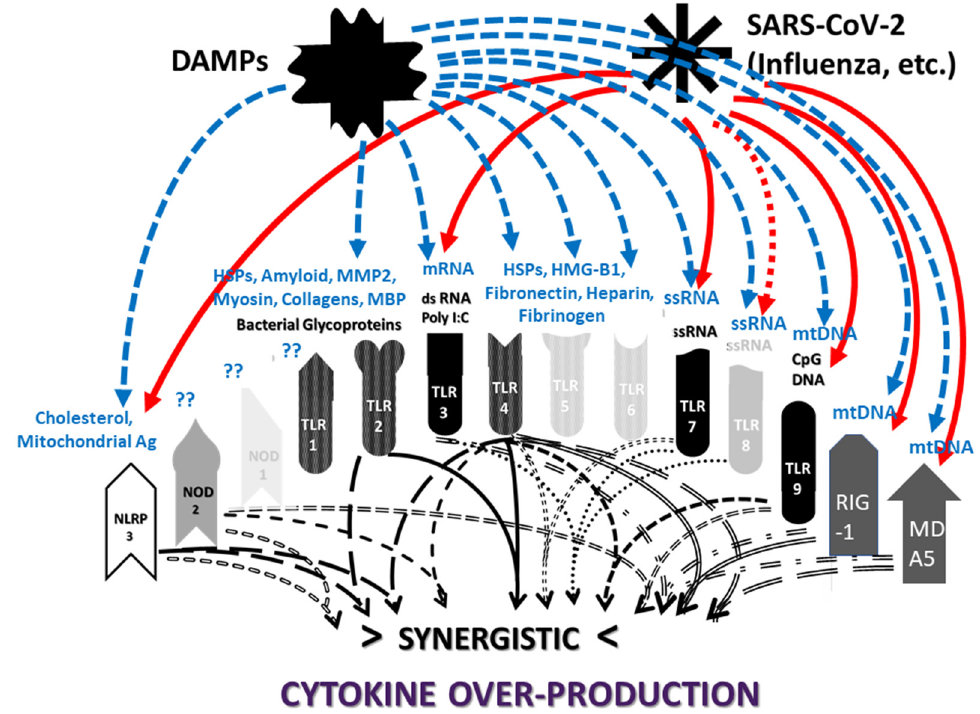
Figure 12. Summary of innate receptor activations produced by SARS-CoV-2 (red lines), damage-associated molecular pattern (DAMP) antigens (blue lines) and their synergisms. Solid red lines indicate activation of receptors that have been well-validated by experimental or clinical studies. Dotted red lines indicate possible activation by SARS-CoV-2 antigens that are not well-established. Dotted blue lines indicate receptor activation by DAMPs that may or may not be released in any given patient with severe COVID-19 and may therefore be disease-, organ-, or tissue-specific. The black lines indicate pairs of receptors involving well-established activation patterns that produce synergism in COVID-19 (see Figure 11). Ag = antigens; ?? indicates that DAMP activators are not known; HSP = heat-shock proteins; MMP2 = matrix metalloproteinase-2 (collagenase); MBP = myelin basic protein; mRNA = messenger ribonucleic acid; HMG-B1 = High-mobility group box 1 protein, ssRNA = single ‑ stranded ribonucleic acid; mt DNA = mitochondrial deoxyribonucleic acid.